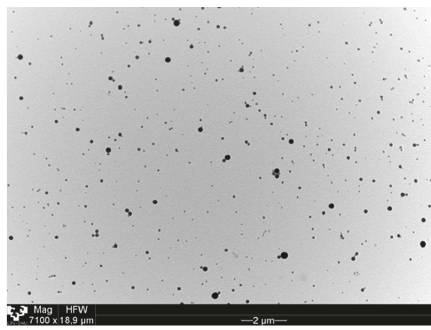
Figure 4: Micrography of particles obtained at pH of 1.75, 15 ∘ C, 0.08 g of TW80, 1g of ECA, and 0.25 g of IB.